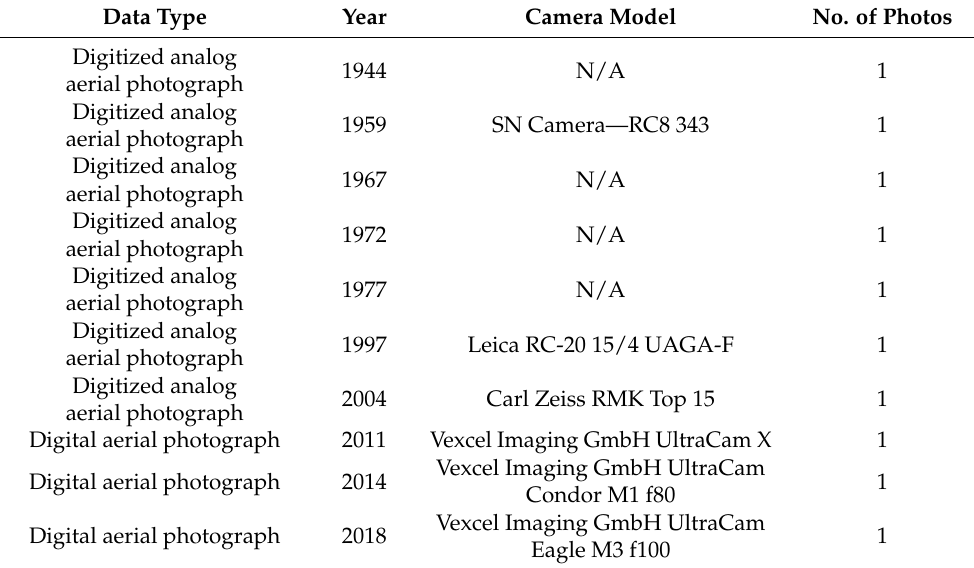
Table 2. Overview of aerial photogrammetric data acquired for LUCC analysis of Ošljak